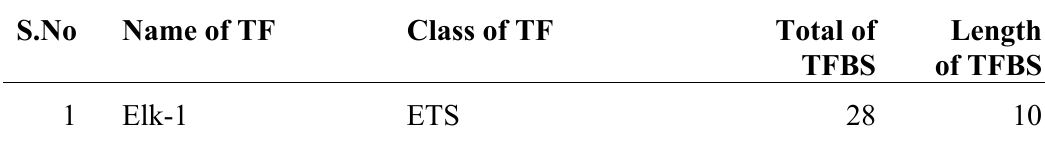
Table 2: Human transcription factors with the recognized TFBS and their lengths